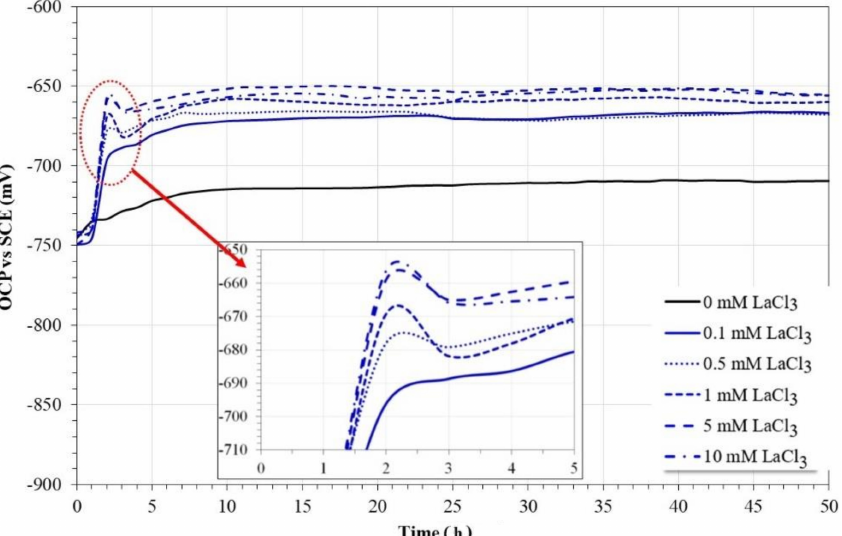
Figure 2. Evolution of OCP values for 1018 carbon steel in CO 2 -saturated brine at different concentra- tions of lanthanum